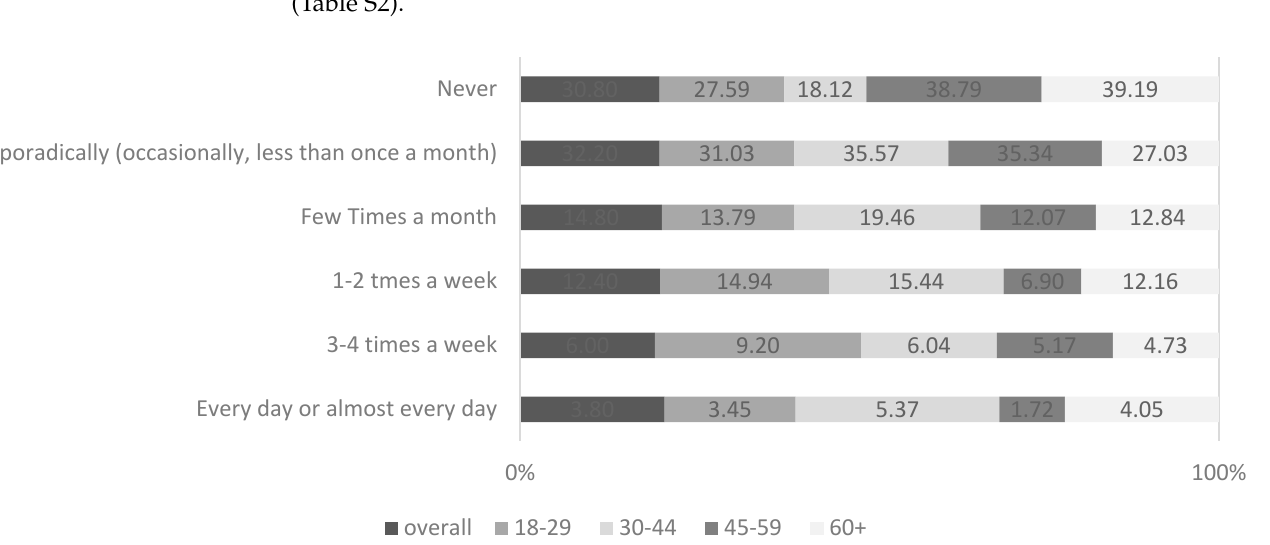
Figure 1. The age of the respondents versus the frequency of energy drinks consumption n = 500.